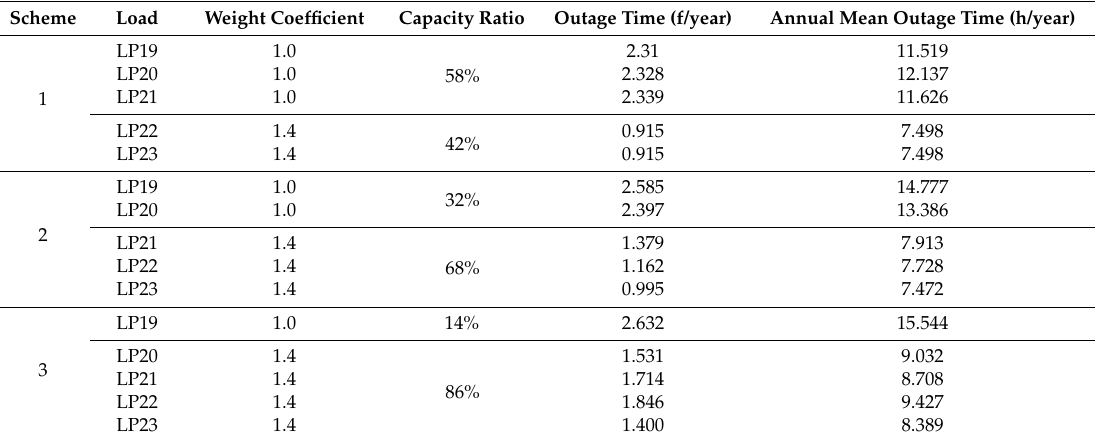
Table 3. System Reliability